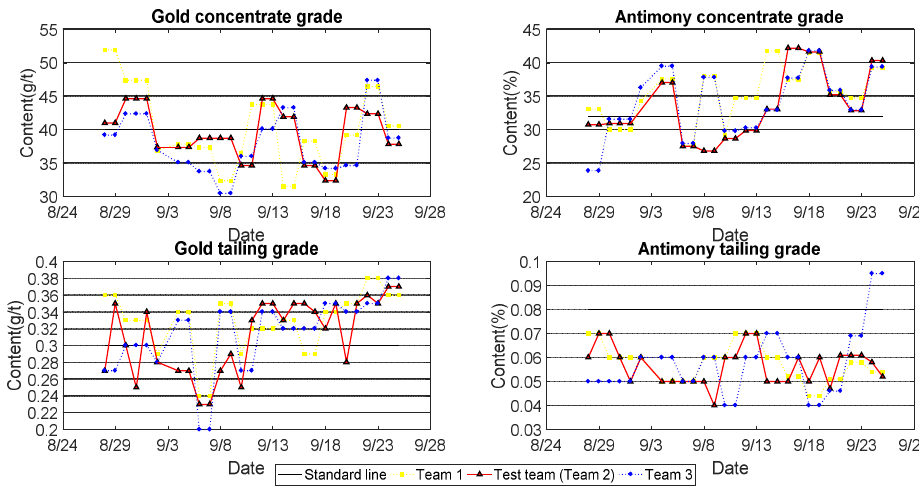
Figure 8. Monitoring results of concentrate and tailing grade. Table 13. Technical indices of each team.